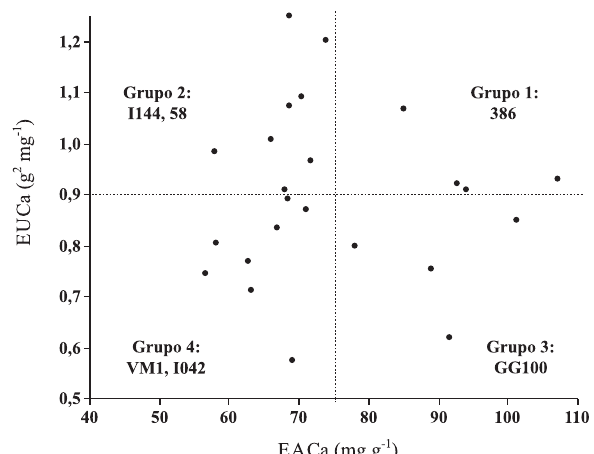
Figura 5. Diagrama de distribuição dos clones de eucalipto em função das eficiências de absorção (EA) e de utilização (EU) de